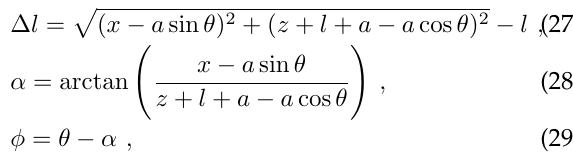
coordinates defined on Fig. 5. The inverse